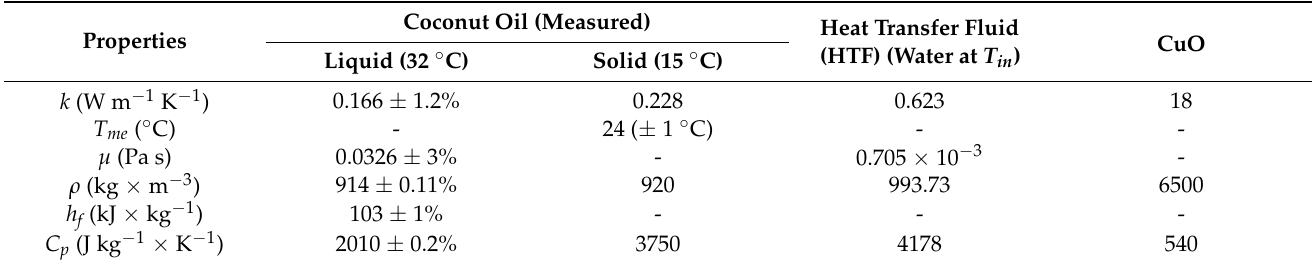
Table 1. Properties of LHTES materials [24,25].